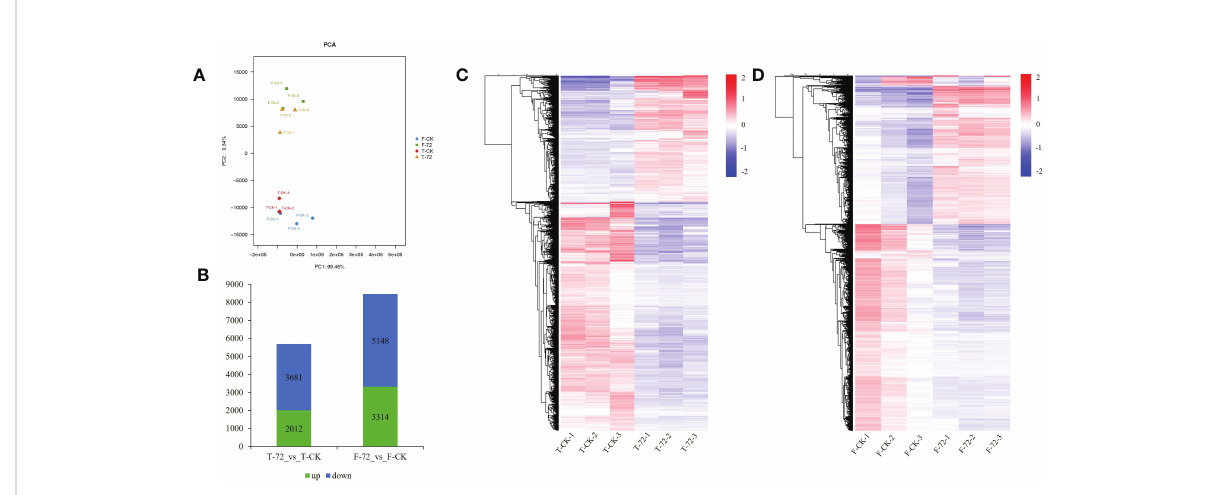
FIGURE 3 Transcriptome analysis in roots of TX9425 and Franklin under control and waterlogging conditions. (A) Principal component analysis (PCA) of transcript changes separates the samples under control and waterlogging (72h waterlogging treatment) conditions. Horizontal and vertical coordinates respectively represent the fi rst and second principal components, and the contribution degree of each principal component is in parentheses. (B) Number of upregulated genes (green) and downregulated genes (blue) between barley under waterlogging stress and normal conditions. (C) Heatmap clustering of the DEGs in TX9425 according to their expression abundance. (D) Heatmap clustering of the DEGs in Franklin according to their expression abundance. The different colors indicate different levels of expression abundance.